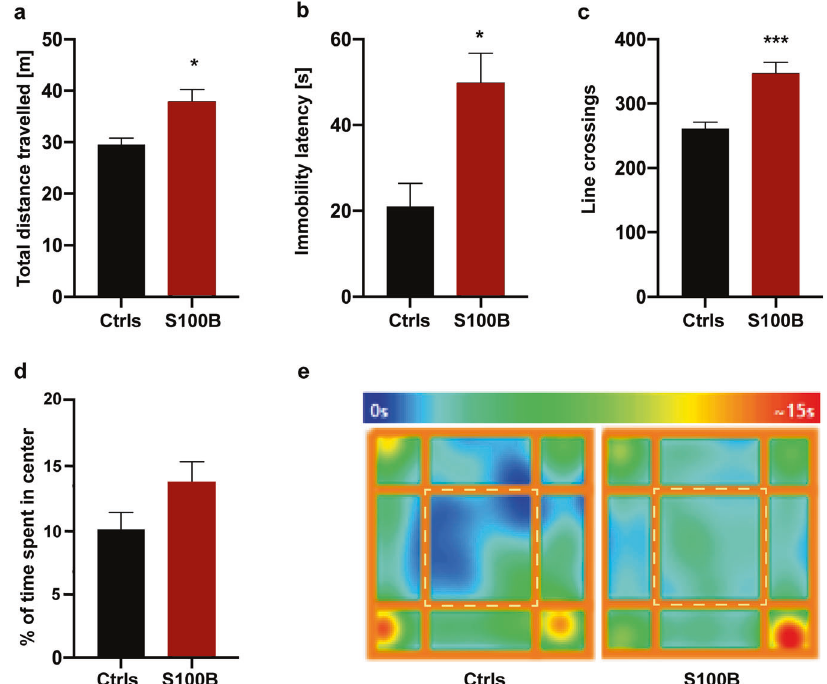
Fig. 5 S100B injection during late embryogenesis induces motor hyperactivity in the adult. The motor performance and anxiety-like behavior were assessed in the open fi eld task (Ctrls, n = 15; S100B, n = 36): a S100B mice show increased total distance ( p = 0.045), ( b ) increased latency to the fi rst immobility episode ( p = 0.012) and ( c ) higher number of line crossings ( p < 0.001) compared to Ctrls. d No signi fi cant difference was detected for the time spent in the center zone between the two groups ( p = 0.126). e Occupancy plots of the two groups of mice. The center zone is indicated by the dashed square. Statistical analysis according to Mann – Whitney U